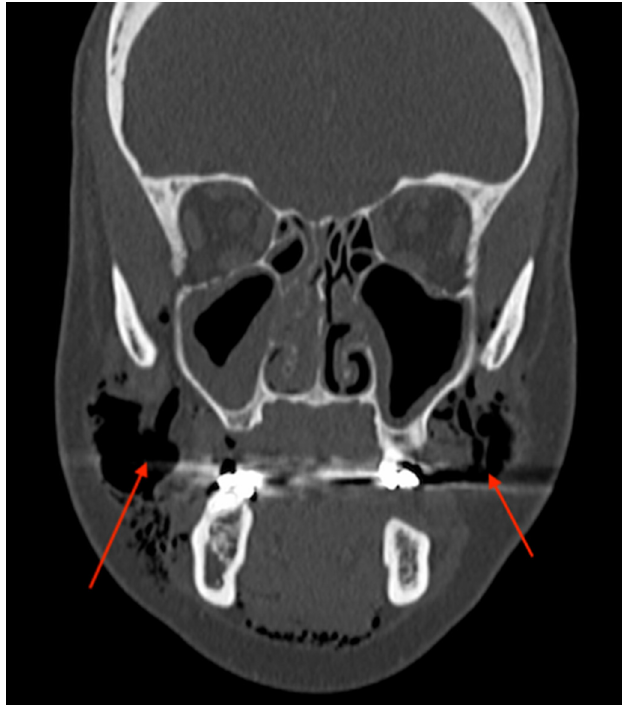
Fig. 3. Frontal head and neck computed tomogram. Cervico-facial tissues emphysema, dissecting the different muscle planes, extending from the temporal muscles to the emergence of supra-aortic